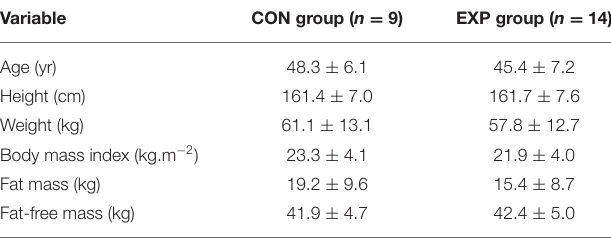
TABLE 1 | Descriptive characteristics of the participants at baseline.